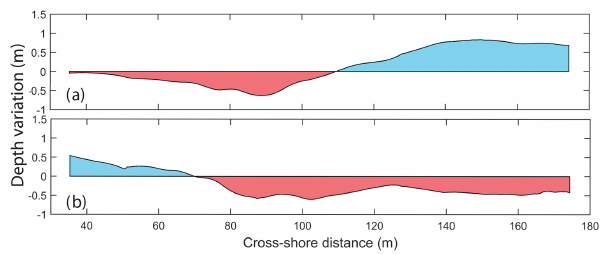
Figure 9. Depth variation estimated from bathymetry inversion of the time stack during storm conditions; (a) between 8 April and 20 March (storm conditions); (b) between 12 June and 8 April (calm conditions).